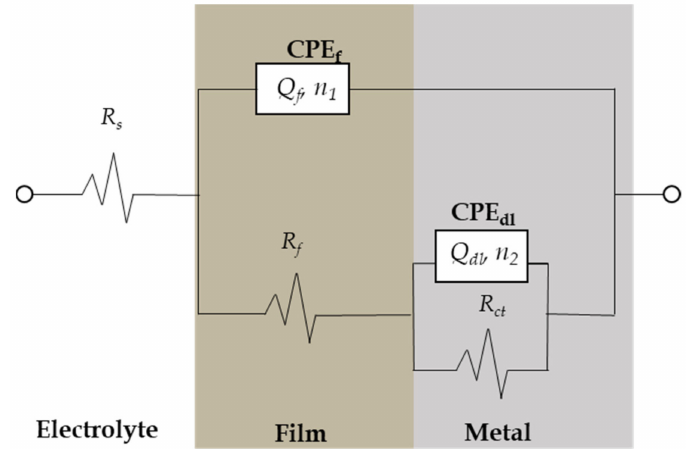
Figure 10. Equivalent circuit model used to fit experimental impedance data of CSX36 corrosion in the studied Jeddah soil solutions at 30 ± 1 ◦